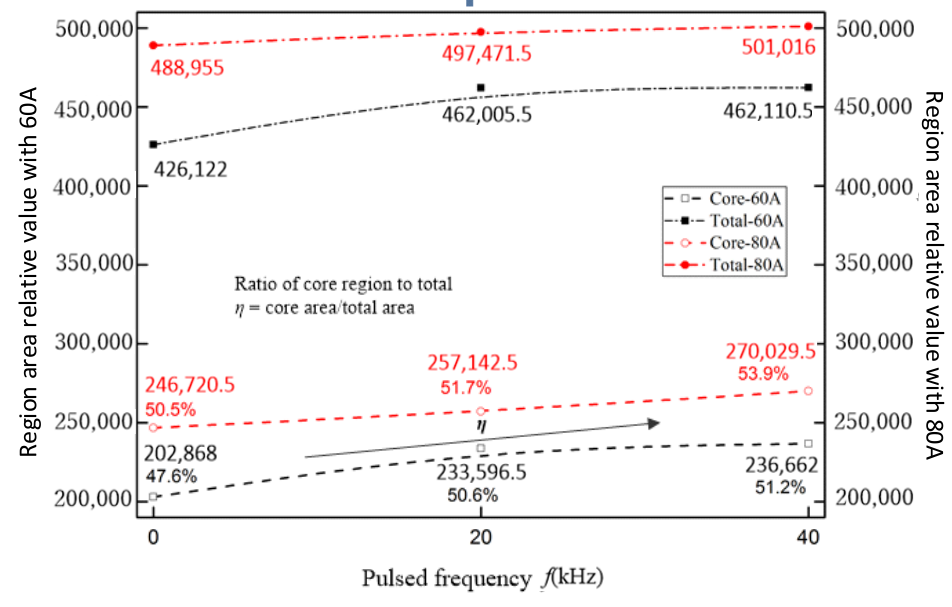
Figure 4 . Front view of the arc and top ‐ down view sliced in the maximal radius of the arc.